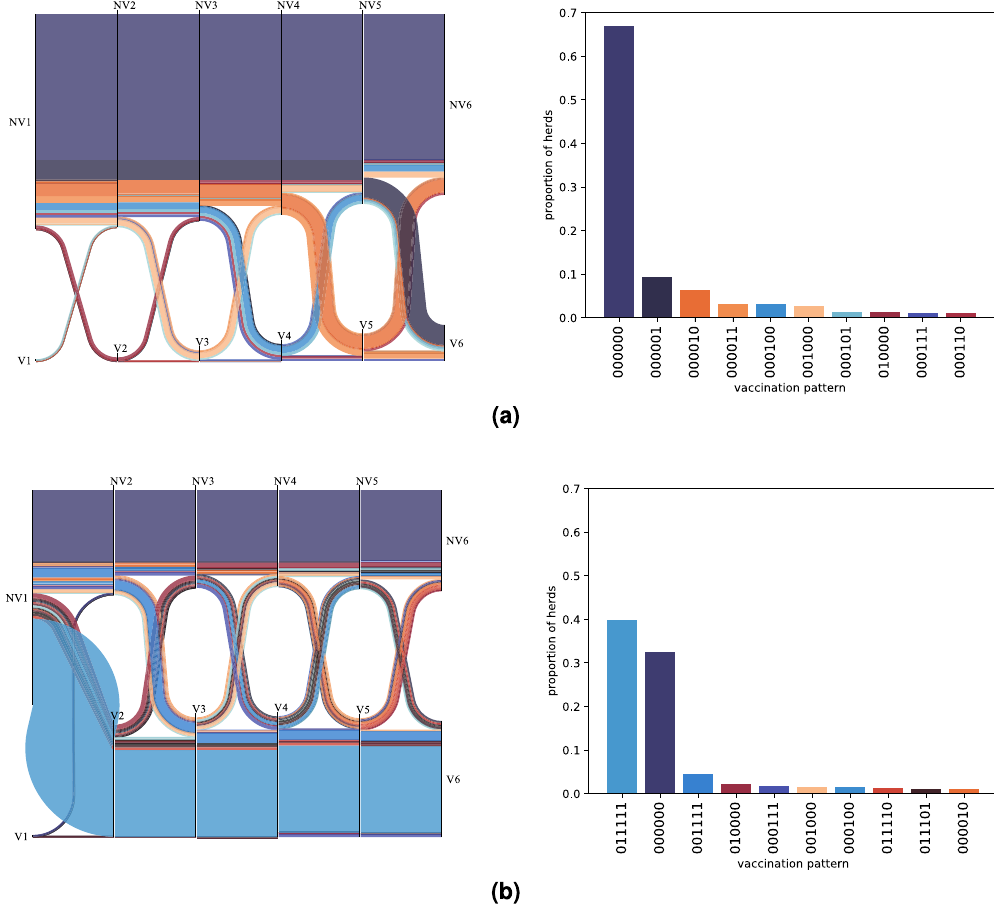
Figure 4. Temporal dynamics of the vaccination decisions using the decision mechanism defined in Algorithm 1 with κ = 0.5 ( a ), and κ = 12.5 ( b ). Results for one run. NV and 0 stand for not vaccinating, while V and 1 for vaccinating. Each color represents a different vaccination pattern, defined by the sequence of vaccination decisions at each of the six decision times. So the pattern 001111 (or equivalently [NV1, NV2, V3, V4, V5, V6]) concerns herds that do not vaccinate at the two first decision times, and always vaccinate afterwards. In the left plots, each vertical black line represents a decision time, and the width of the flows between decisions is proportional to the frequency of the pattern. In the right plots, the histogram of the patterns with a frequency > = 1% is plotted. Hence, in (a), 67% of herds never vaccinate (pattern 000000). In (b), 39% of farms always vaccinate except in the first instant (pattern 011111), and 33% never vaccinate (pattern